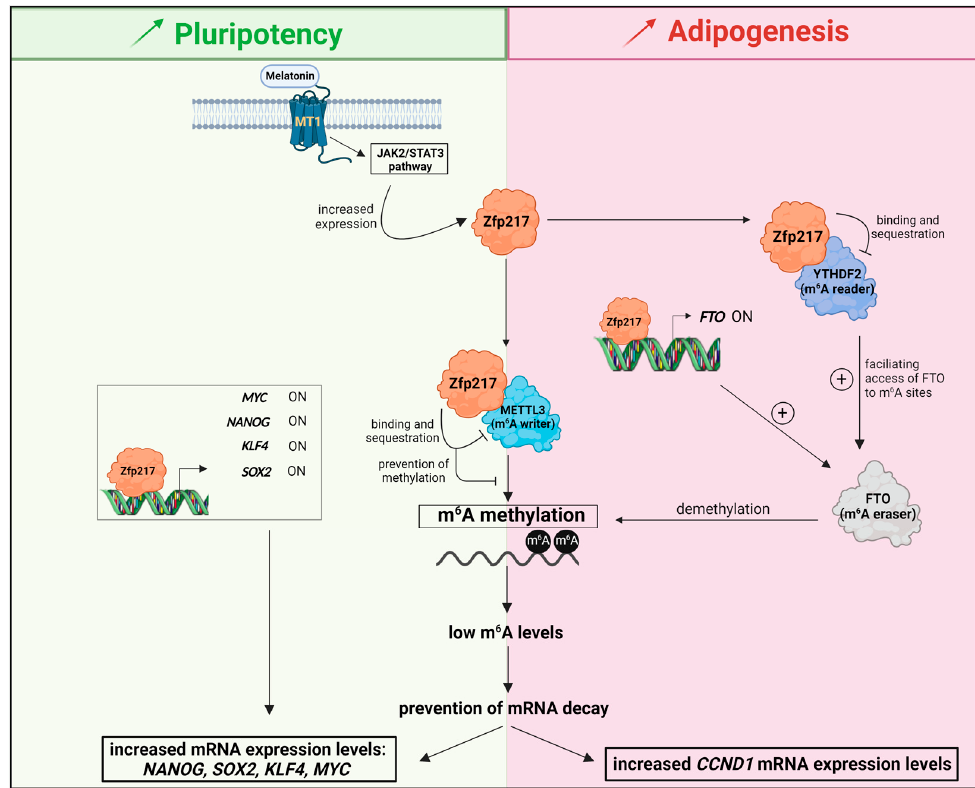
Figure 2. Zfp217 enhances pluripotency and adipogenesis by regulating the epitranscriptome. Created with